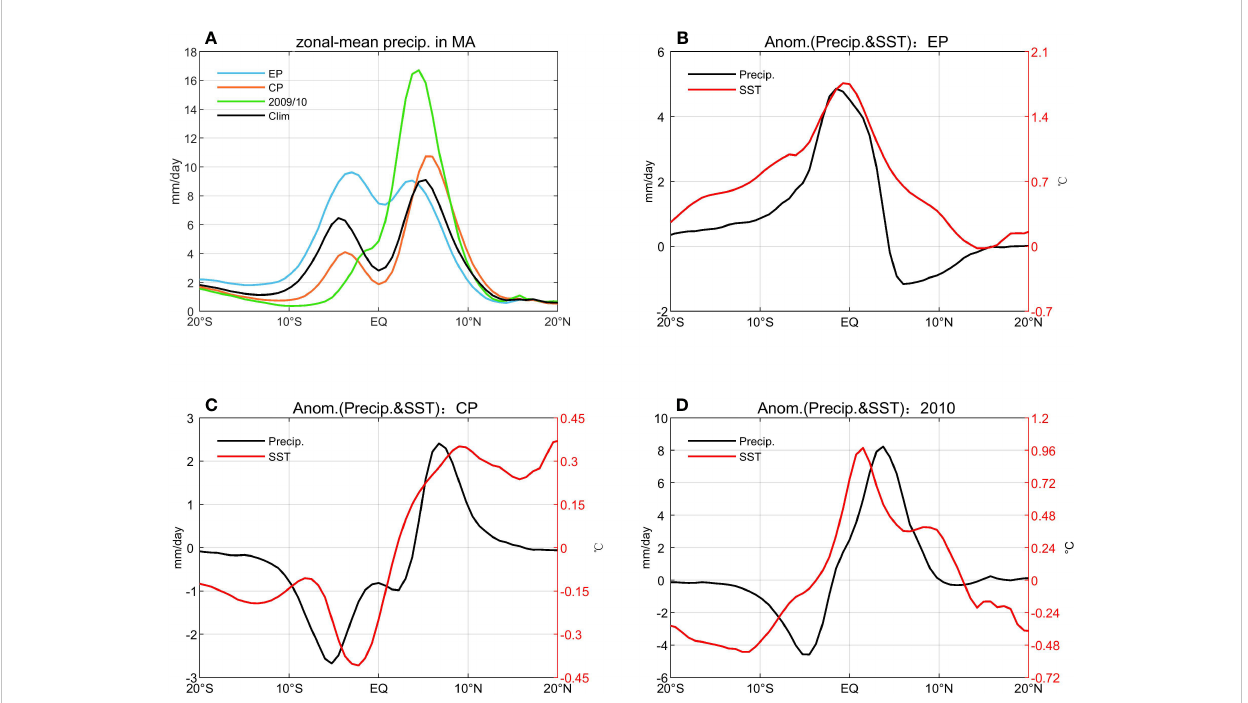
FIGURE 3 (A) zonal-mean precipitation (units: mm/day) over the eastern Paci fi c Ocean (140°W – 80°W) in March-April for: composite of EP-type El Niños (blue), composite of CP-type El Niños (orange), 2009/2010 mixed-type El Niño (green) and climatology (black). Anomalous zonal-mean precipitation (black; units: mm/day) and SST (red; units: °C) for three types of El Niños in March-April: (B) the composite of EP-type El Niños; (C) the composite of CP-type El Niños and (D) the 2009/2010 mixed-type El